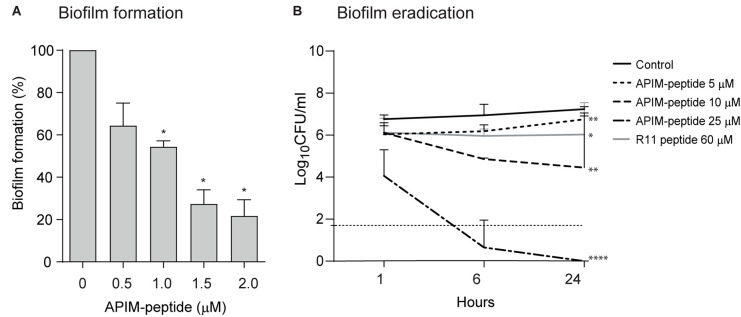
Effect of APIM-peptides on development and eradication of S. epidermidis biofilm. (A) Christensen’s biofilm microtiter plate test using S. epidermidis ATCC 35984. Sub-MIC doses of APIM-peptide (0.5–2 μM) and water (control) added at the same time as the bacteria. Biofilm formation assessed after 24 h. Average biofilm formation from three independent experiments, minimum 3 wells per sample, are shown. Two-tailed, paired Student’s t-test *p < 0.05. (B) Biofilm killing experiment. Biofilm was established on steel rods by growing ATCC 35984 for 5 days before addition of 5 (MIC), 10, and 25 μM of APIM-peptide, and 60 μM of the cell penetrating peptide in the APIM-peptide, R11. CFU determination of the steel rods 1, 6, and 24 h after peptide addition, plotted as average from three independent experiments, are shown. The dotted horizontal line shows the detection limit of CFU/mL, but when no colonies were found, 0 is used for calculation of the average. Two-tailed, unpaired Student’s t-test at 24-h timepoint, *p < 0.05, **p < 0.01, ****p < 0.0001.